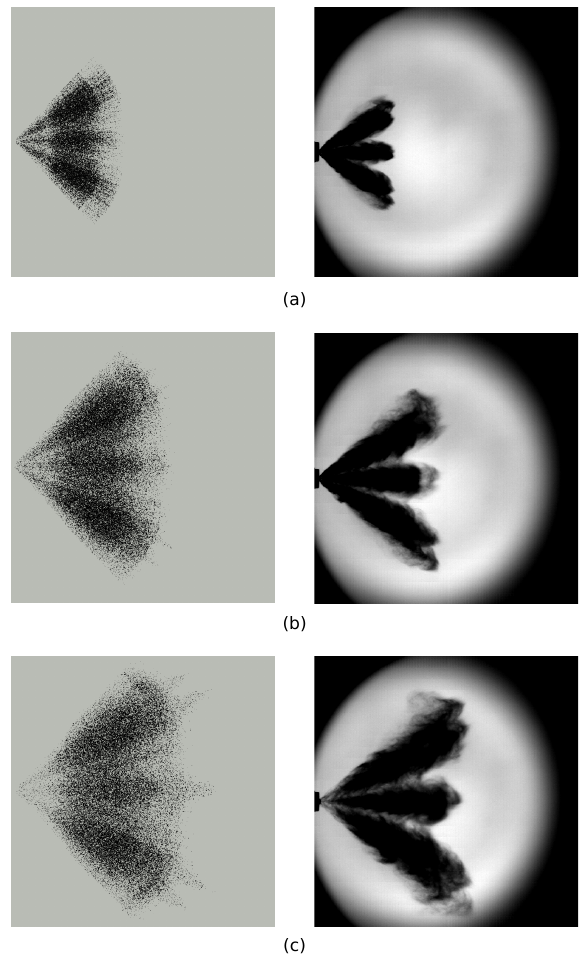
Figure 11. Numerical ( left ) vs. CMT experimental ( right ) liquid morphology images for the G2 cold condition for iso–octane. ( a ) at 0.3ms, ( b ) at 0.6ms and ( c ) at 0.9ms after